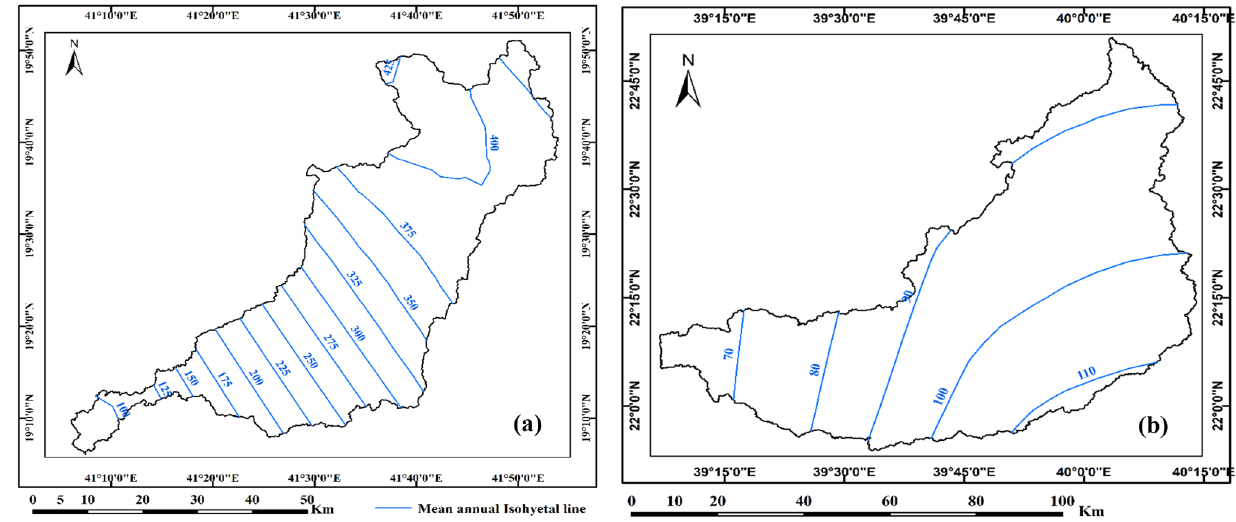
Fig. 2 Annual distribution maps of mean rainfall (mm) in Wadi Qanunah ( a ) and Wadi Marawani ( b ), Makkah Al-Mukarramah Province, Saudi